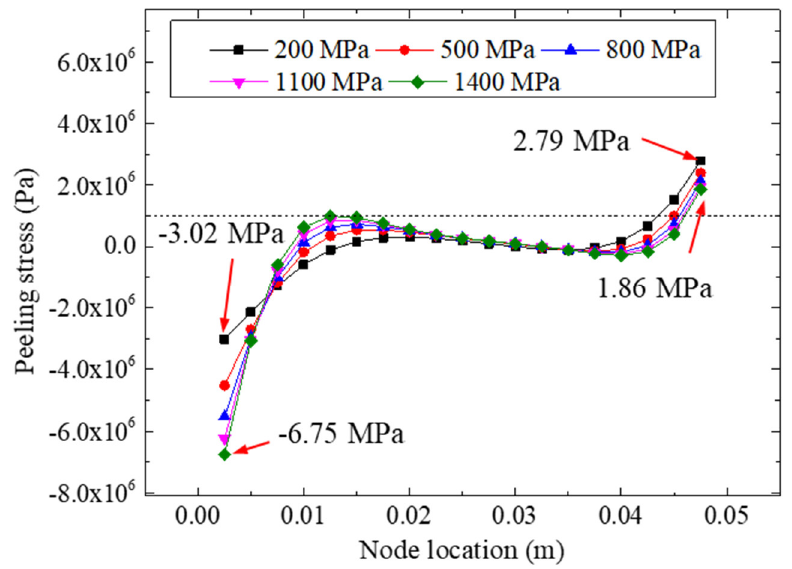
Figure 17. Peeling stresses for different adhesive modulus.